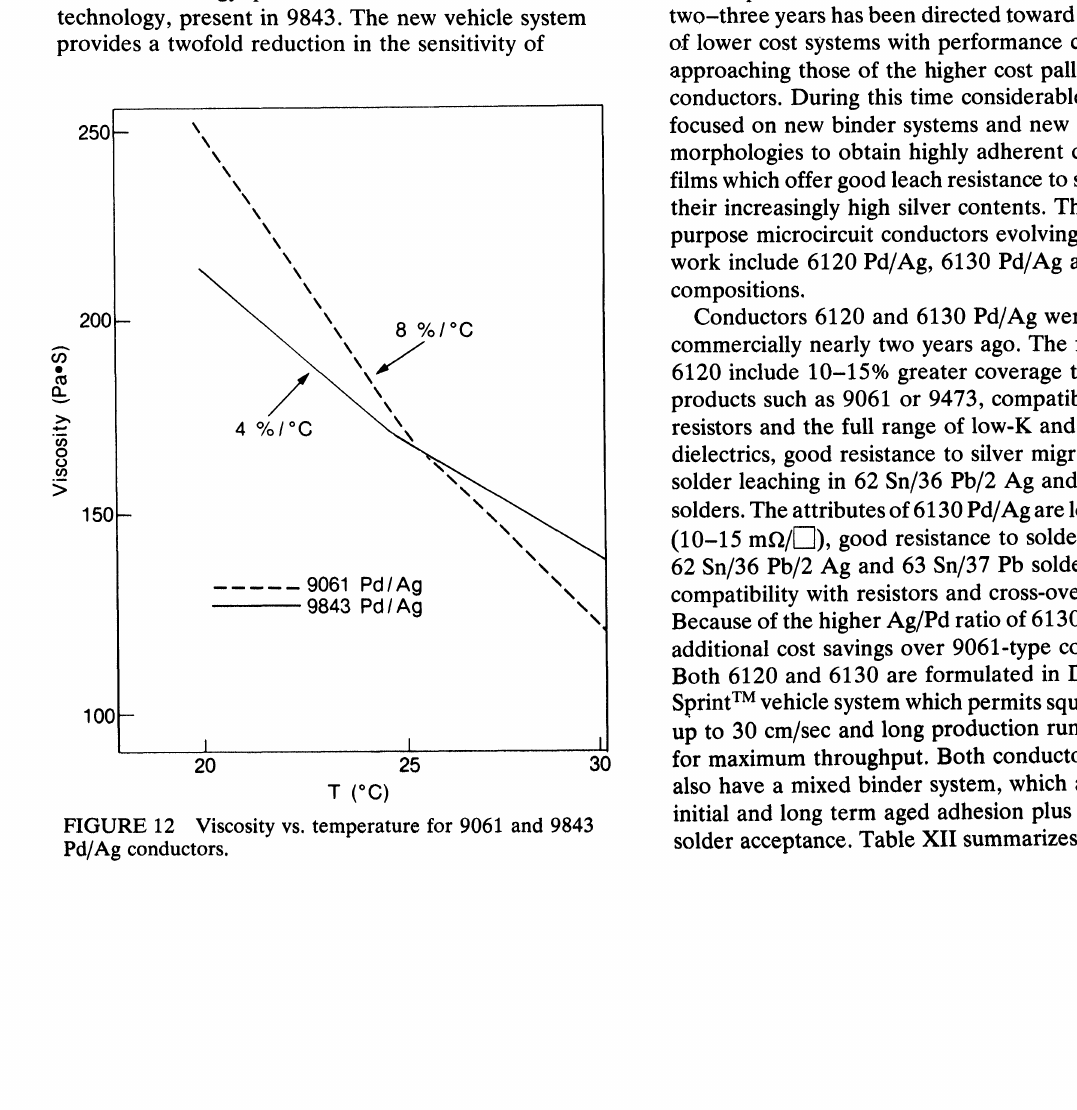
FIGURE 12 Viscosity vs. temperature for 9061 and 9843 Pd/Ag